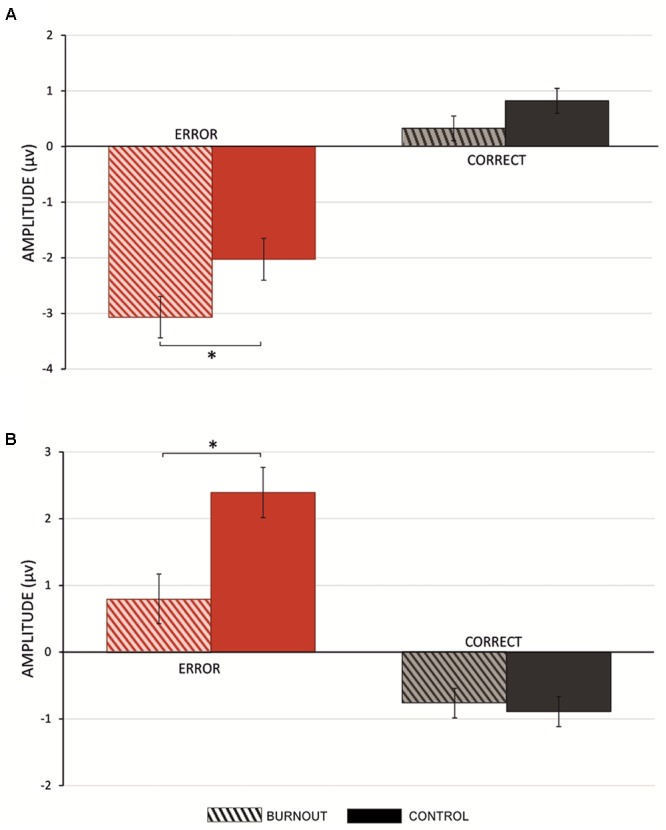
(A) Mean amplitudes of post-error (red) and post-correct (gray) response ERP waveforms in a time-window of ERN for burnout and control group. (B) Mean amplitudes of post-error (red) and post-correct (gray) response ERP waveforms in a time-window of error positivity (Pe) for burnout and control groups. Vertical bars denote standard errors; asterisks denote statistically significant differences.